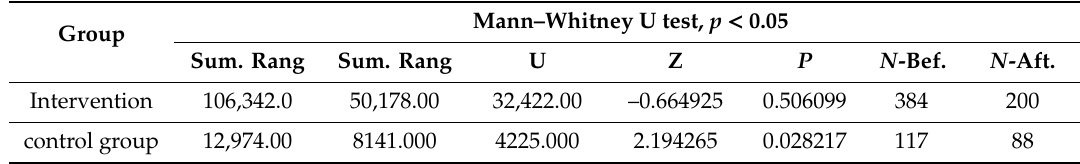
Table 6. Summary of Mann–Whitney U test from results of questionnaires before and after